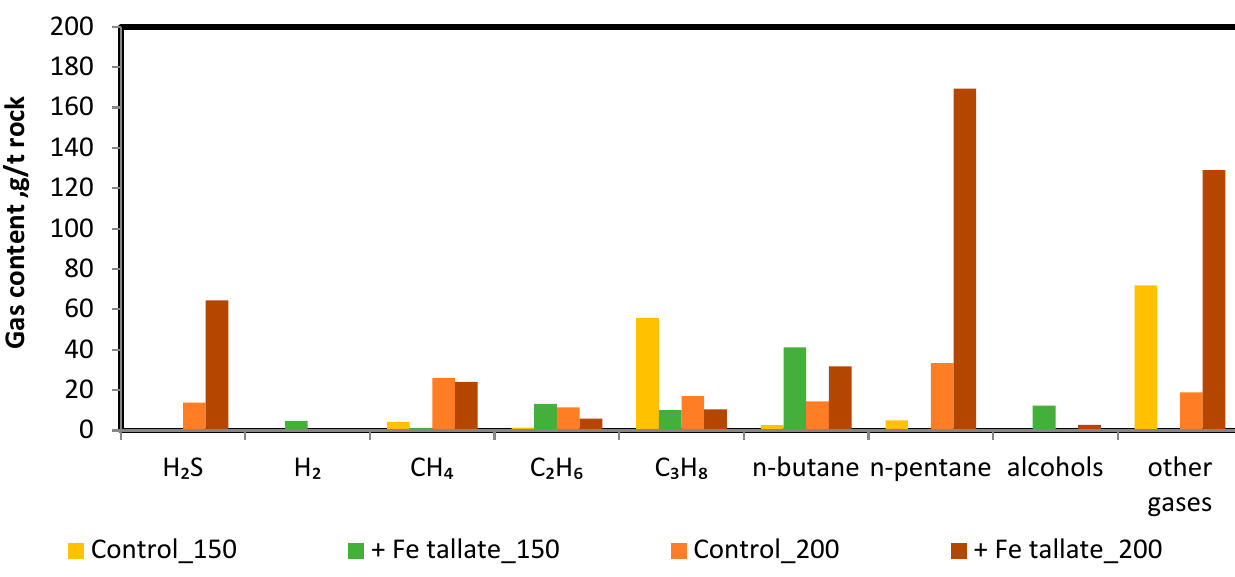
Figure 1. X-ray diffraction analysis of the original rock.